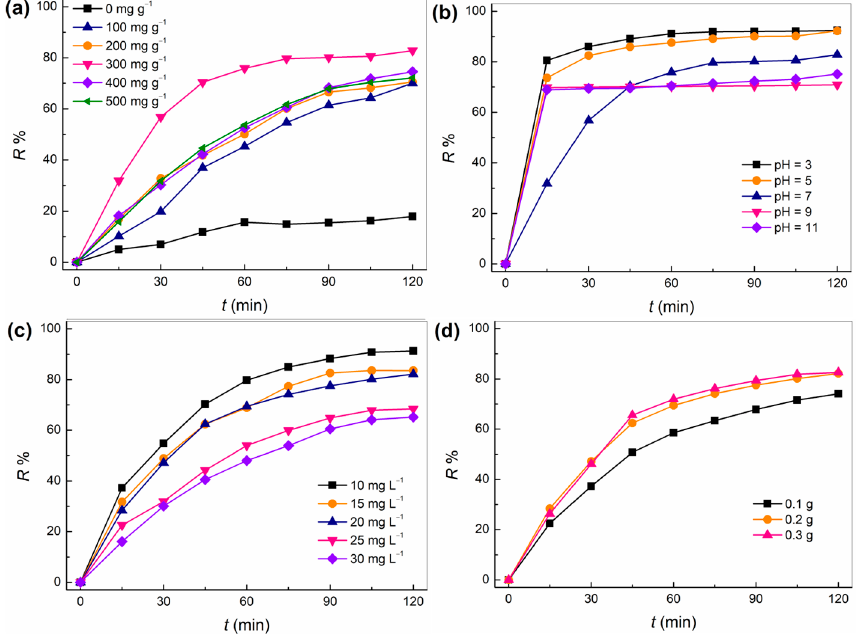
Figure 6. E ff ect of nano fi ber photocatalysis fi lm on catalytic performance: ( a ) loading amount, ( b ) Figure 6. Effect of nanofiber photocatalysis film on catalytic performance: ( a ) loading amount, ( b ) pH, pH, ( c ) TC concentration, and ( d ) fi ber fi lm dosage. ( c ) TC concentration, and ( d ) fiber film